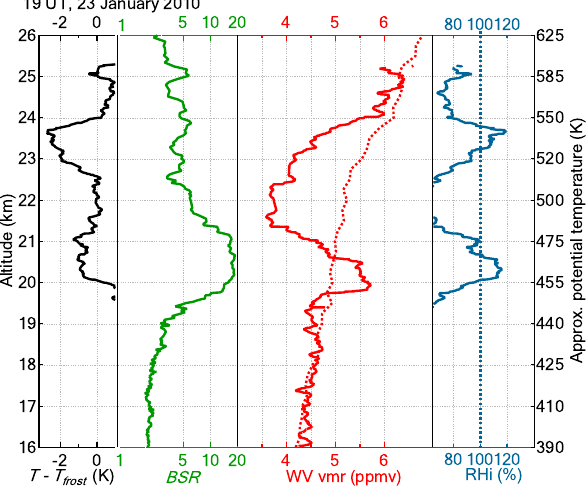
Fig. 3. Vertical profiles obtained during balloon ascent on 23 Jan- uary 2010. From left to right: difference between the observed tem- perature and the “climatological” frost point (based on January mean water vapour from FPH and CFH soundings in 2002–2010, black line); backscatter ratio at 870nm (green); water mixing ratio (CFH), with climatological mean shown as dotted line (red); rela- tive humidity with respect to ice (blue). Note the different vertical and horizontal scaling compared to Fig. 1. The time stamp in the upper-left corner refers to the time of stratospheric